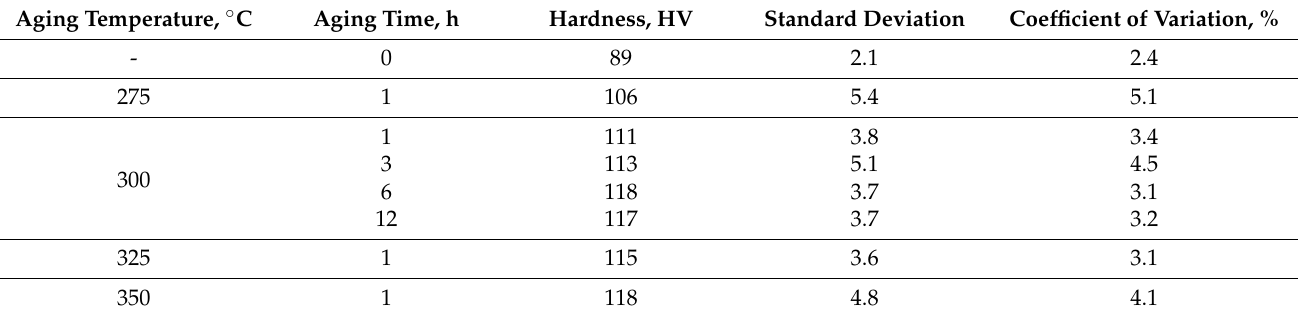
Table 6. Average values of